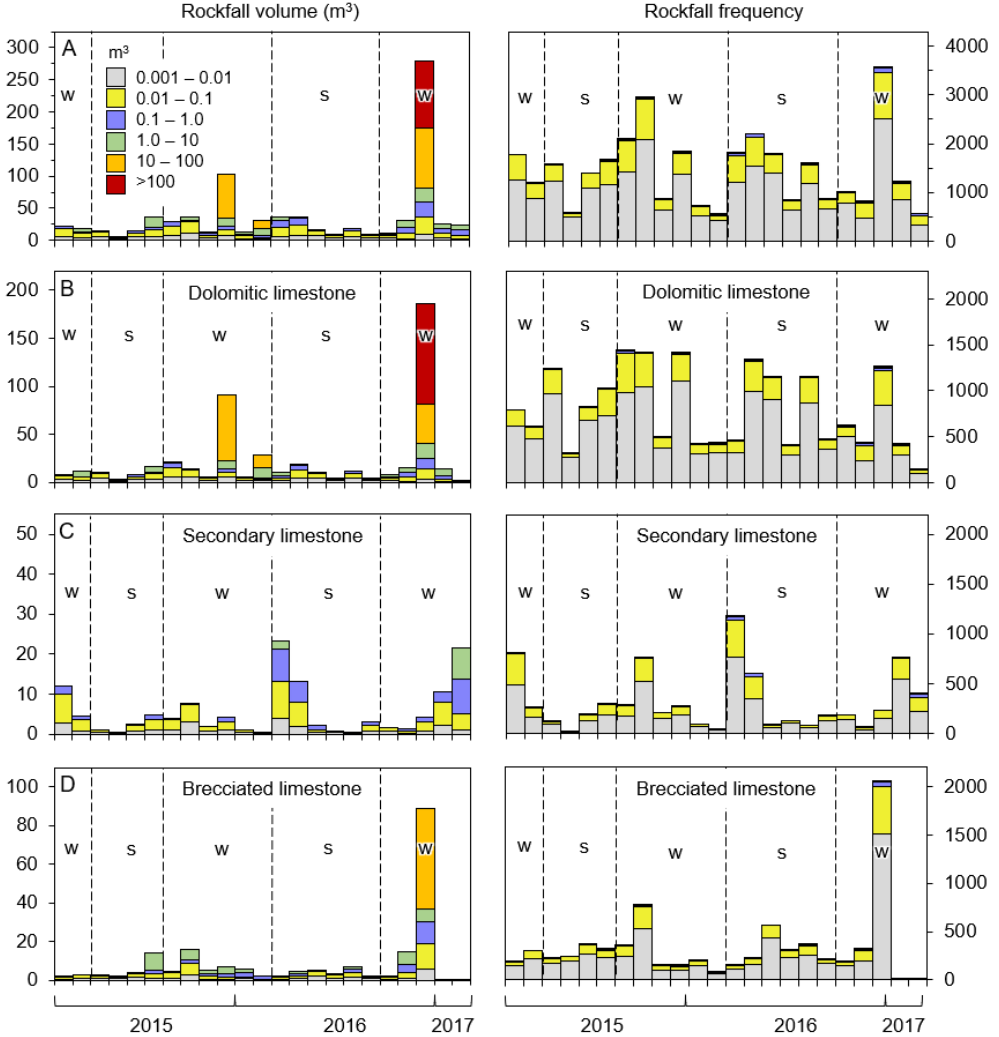
Figure 7. Lithology-specific periodic rockfall volume (column 1) and rockfall count (column 2) contributions. ( A ): Dolomitic limestone; ( B ) Secondary limestone; ( C ): Brecciated limestone. ‘w’ and ‘s’ denote ‘winter’ and ‘summer’ periods, respectively. The key in panel C applies to all panels. Note the y-axis limits for column 1 vary for each panel.